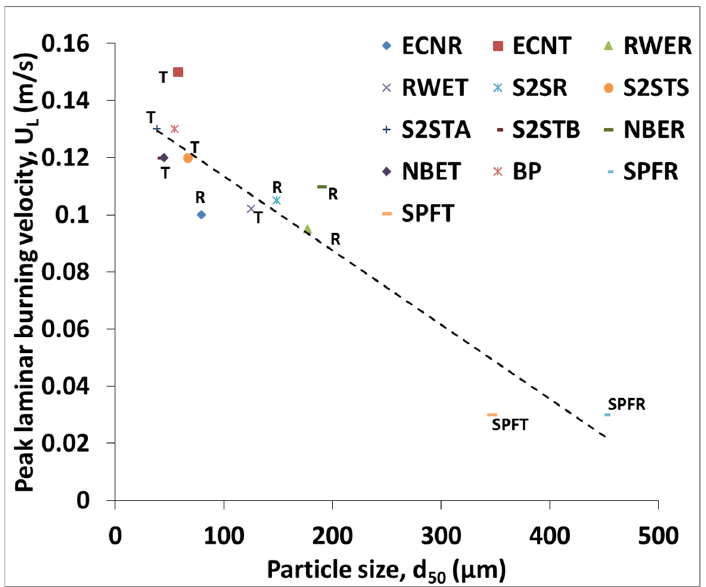
Figure 9. Peak laminar burning velocity (UL, max) as a function of average size for 50% fraction (d50) for present samples in comparison to other results of raw (R) and thermally treated samples (T) [30,39,42,58,59].